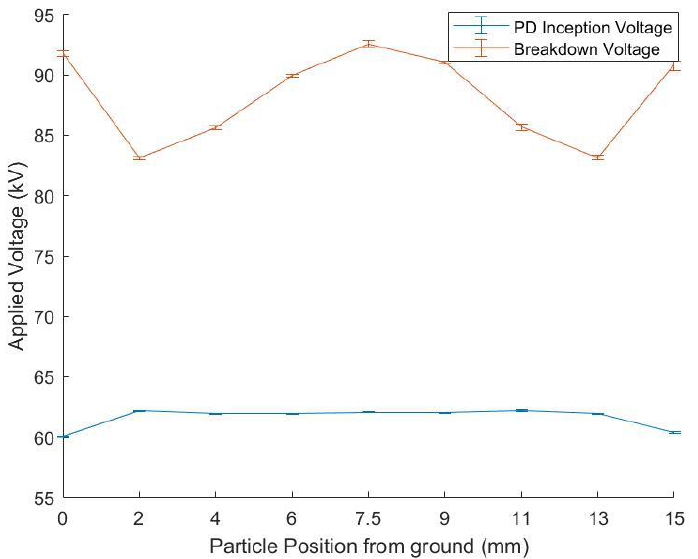
Figure 5. Characteristics of corona inception and breakdown voltages of 5 mm symmetrical particle.